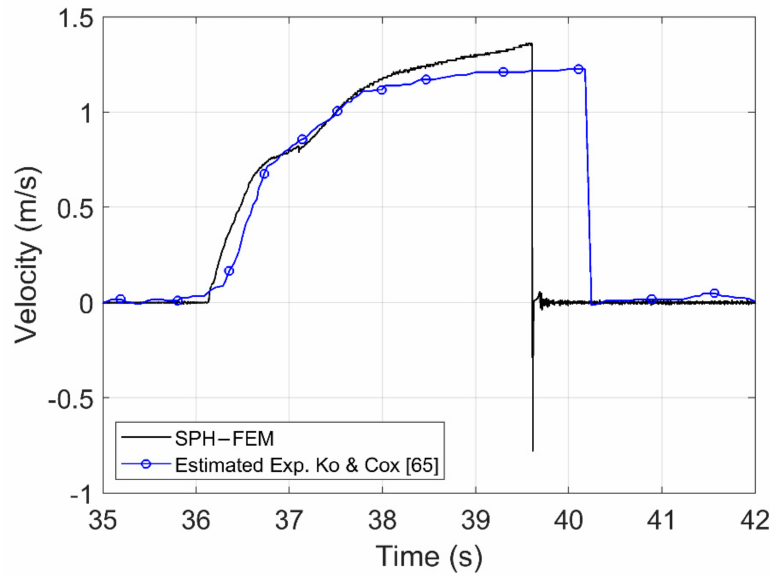
Figure 6. Debris velocity histories: Estimated based on the experimental tests of [65] and results from the numerical simulations for h 1 = 2.496 m, T erf = 30